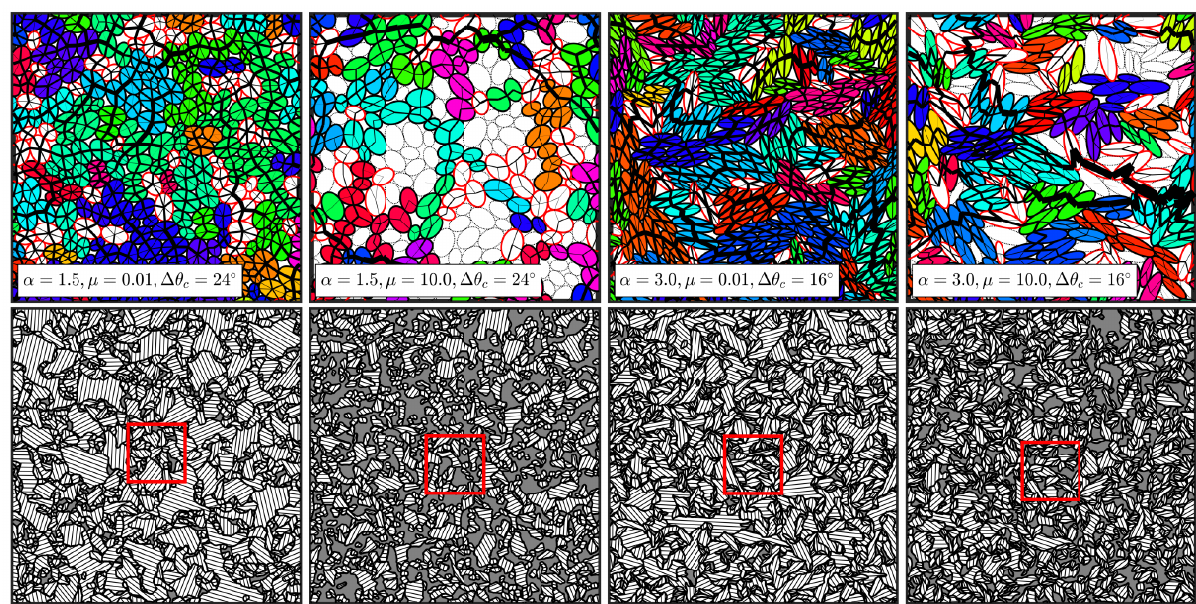
Figure 8. Top: examples of clusters and force networks, with α = 1.5 and 3.0, µ = 0.01 and 10.0. Same-color particles belong to a specific cluster. Particles shown in red lines do not belong to any cluster. Particles shown in doted lines are rattlers. The solid lines connecting particles represent contact forces, with the width representing the force magnitude. Bottom: zoomed-out views of clusters. Each top figure is a zoom-in on the red square area in the figure below it. The areas filled with shadowed lines are specific clusters. The inclinations of the shadowed lines represent the mean orientation of the particles in the cluster. The gray areas are regarded as homogeneous. ∆ θ c is chosen as the mean value in Fig.